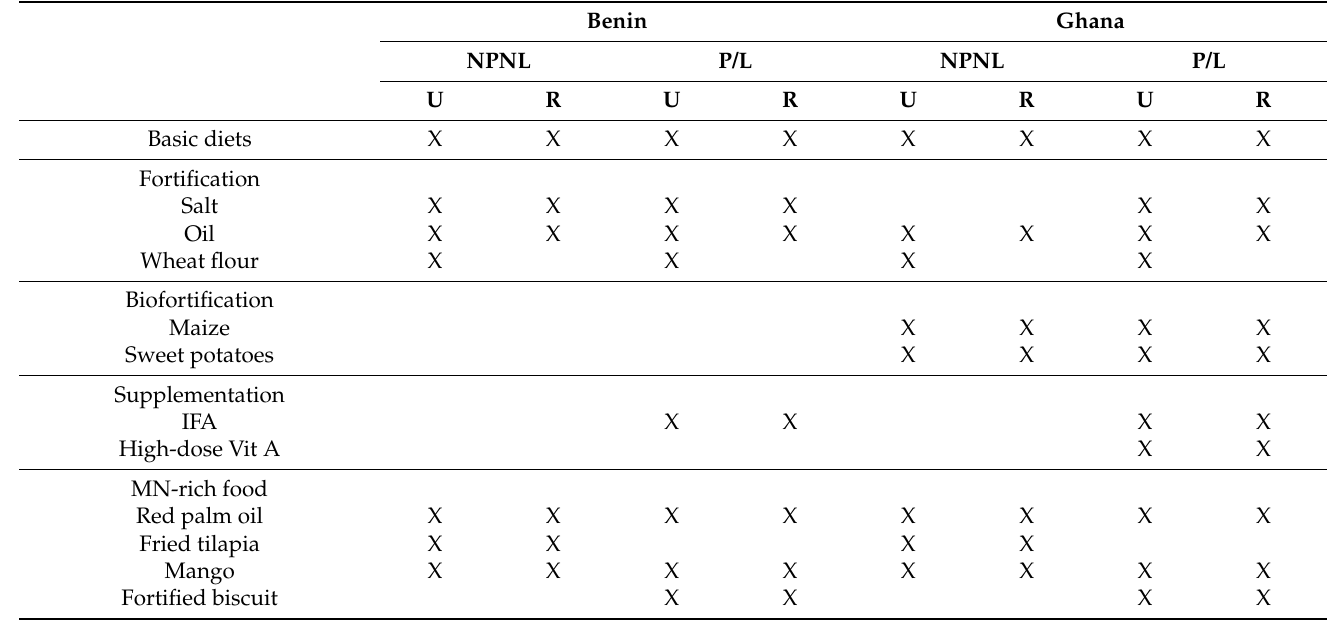
Table 1. Combination of interventions included in the scenarios proposed for non-pregnant and non-lactating women (NPNL), and pregnant or lactating women (P/L), in urban (U) and rural (R) settings. Benin Ghana NPNL P/L NPNL P/L U R U R U R U